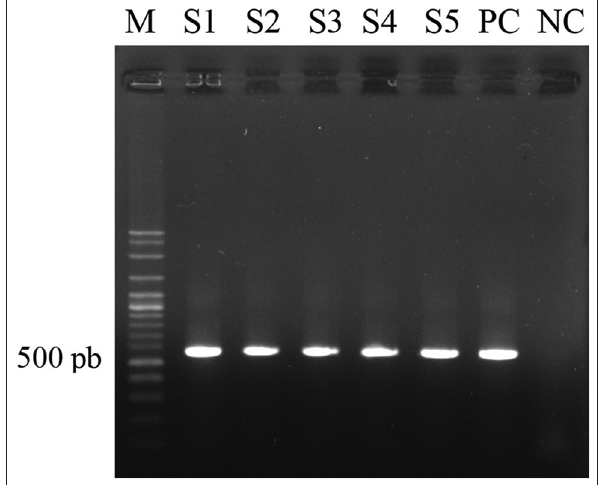
Figure-3: Polymerase chain reaction electrophoresis gel demonstrating Leucocytozoon caulleryi cox I gene amplification with Cox I -F1 and Cox I -R1. M. 100-bp DNA marker ladder, Lanes: 1. Sample1; 2. Sample2; 3. Sample3; 4. Sample4; 5. Sample5; NC, negative control; PC, positive control.